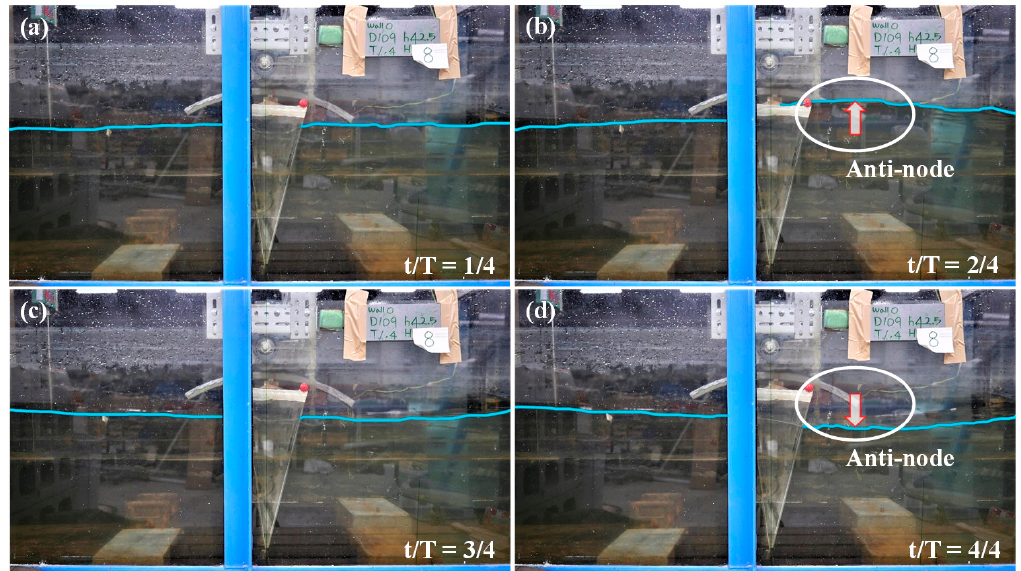
Figure 10. Screenshots for pattern E for the case of D = 1.09 m, h = 0.425 m, T = 1.4 s, and H i = 0.08 m at ( a ) t / T = 1/4, ( b ) t / T = 2/4, ( c ) t / T = 3/4, and ( d ) t / T = 4/4. D / L was 0.4463.